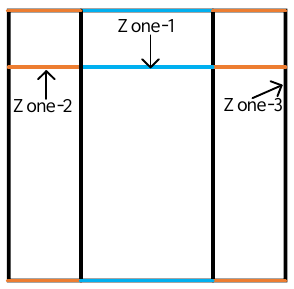
Figure 8. Three mesh seeds layout distribution.